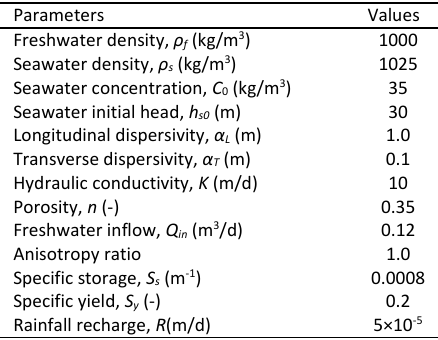
Table 1. The parameters used in the simulation of Table 1: The parameters used in the simulation of hypothetical aquifer hypothetical Parameters